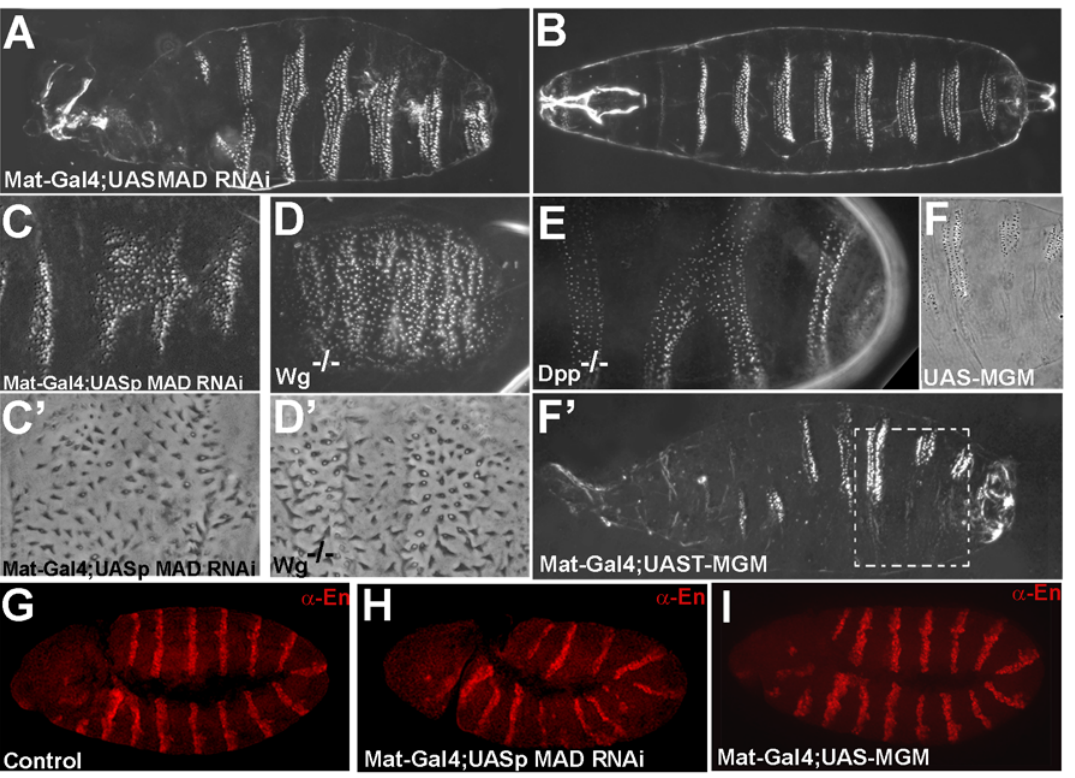
Figure 6. Mad Is Required for Segmentation in Drosophila . (A–B) Early depletion of Mad caused wider (ventralized) denticle belts and internalized posterior spiracles in embryonic cuticles (n=259 cuticles, 20% ventralized and 34% ventralized with denticle belt fusions). (C and C’) Denticle belt fusions showing large (row 5-like) denticles. (D and D’) Wg loss-of-function caused a ventral lawn of denticles. Note that these are large denticles with a small refringent spot (row 5 denticles) resembling those seen in Mad RNAi depletion. (E) Dpp H46 mutant embryo showing fusion of two denticle belts. (F and F’) Overexpression of UAST-MGM driven by mat-Gal4-VP16 caused patches of naked cuticle at the expense of denticle rows. (G–I) Embryos stained for Engrailed at stage 9, showing that Mad depletion disrupts abdominal segmental bands, while MGM overexpression does not.